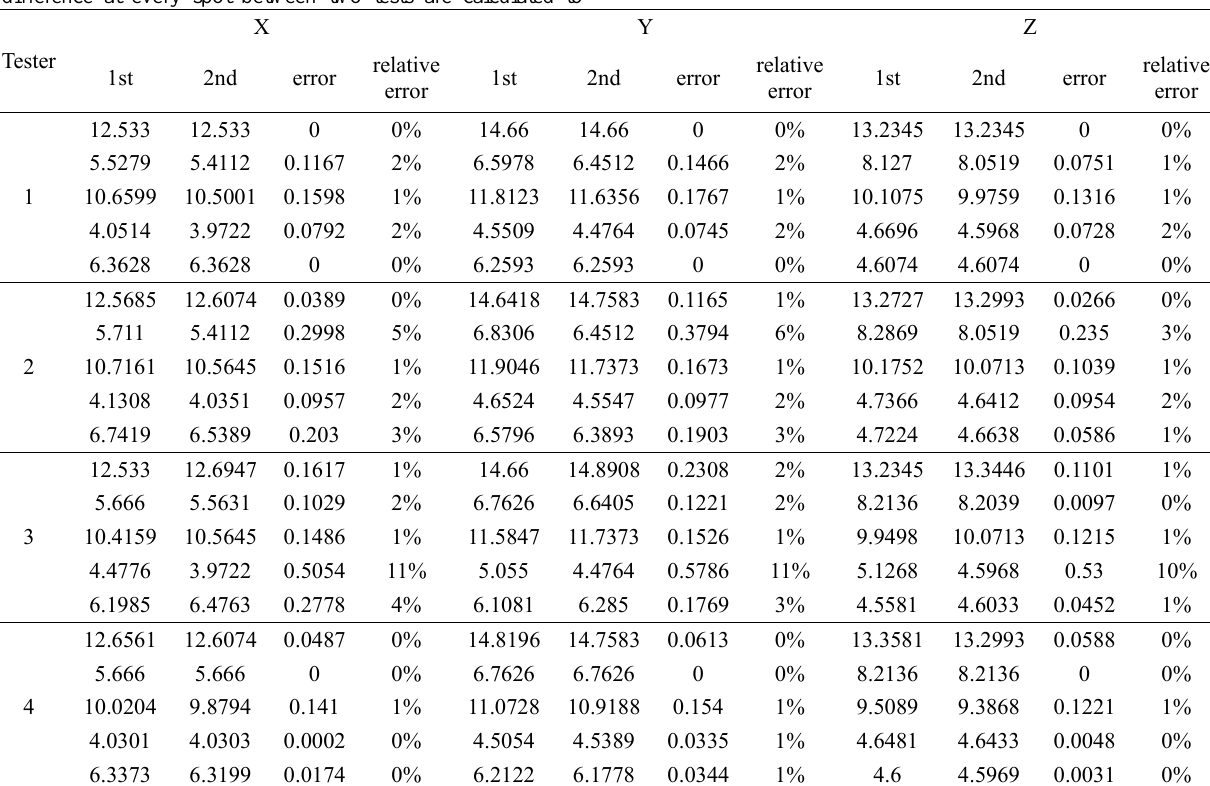
Table 1. Sample points placing error analysis of the east side pattern in Liujia Pavilion